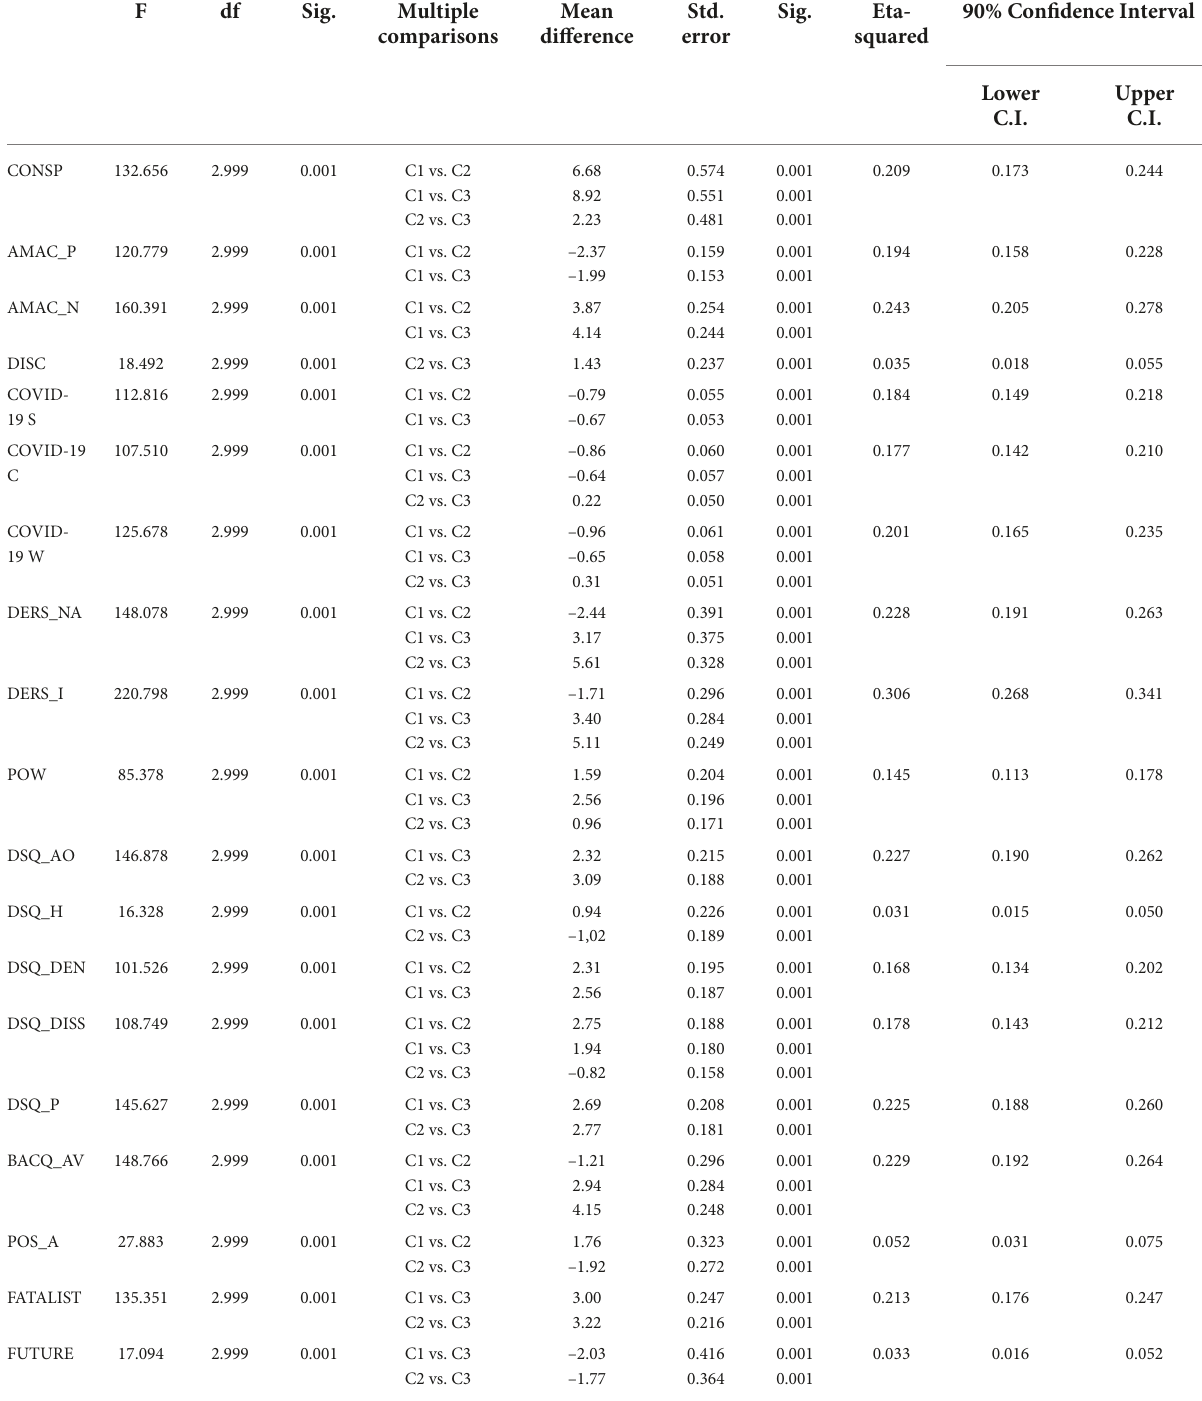
TABLE 5 Differences between groups on COVID-related